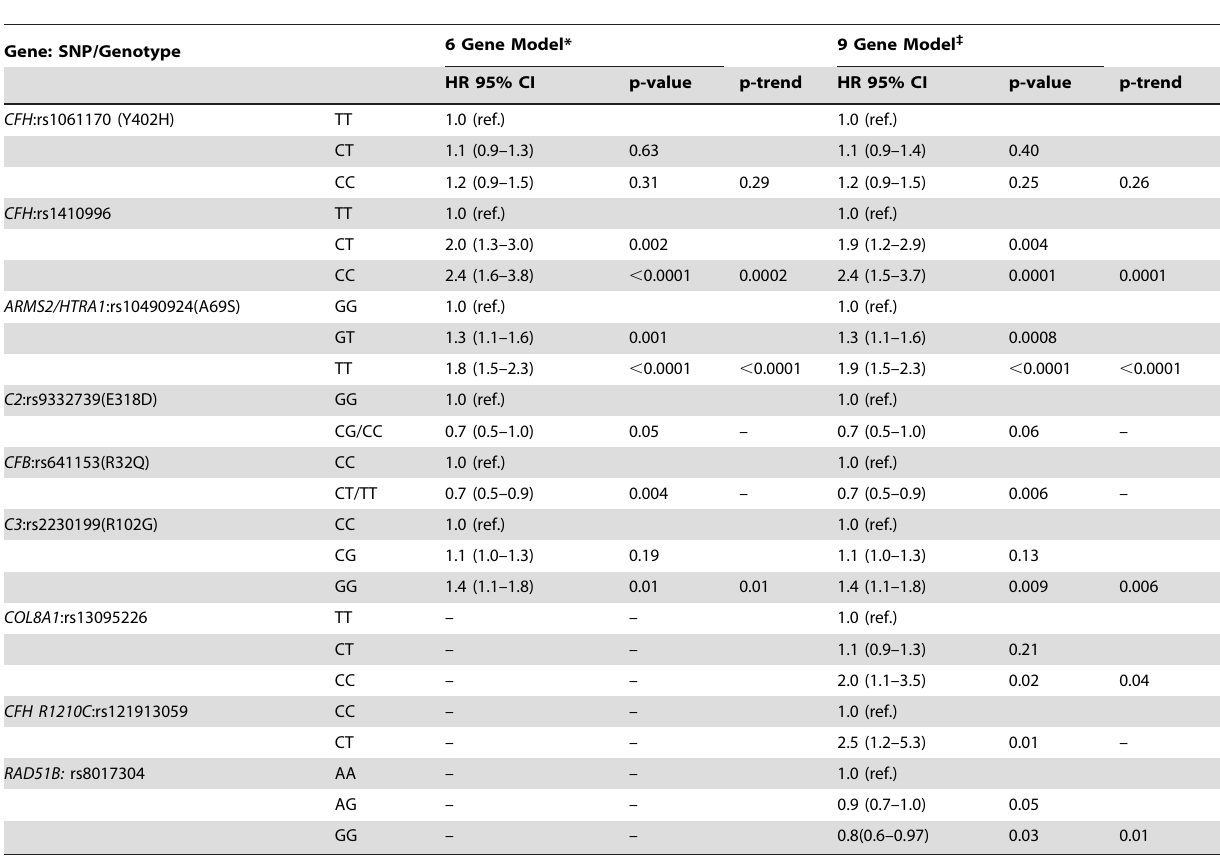
Table 4. Multivariate Associations Between Genes and Progression to Advanced Age-Related Macular Degeneration.